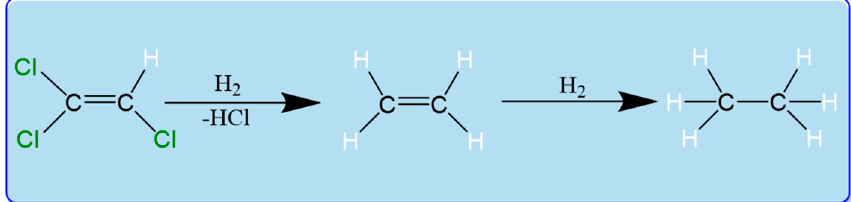
Figure 8. Selective hydrodechlorination (HDCl) of TCE to ethylene. Full hydrogenation to ethane should be avoided.